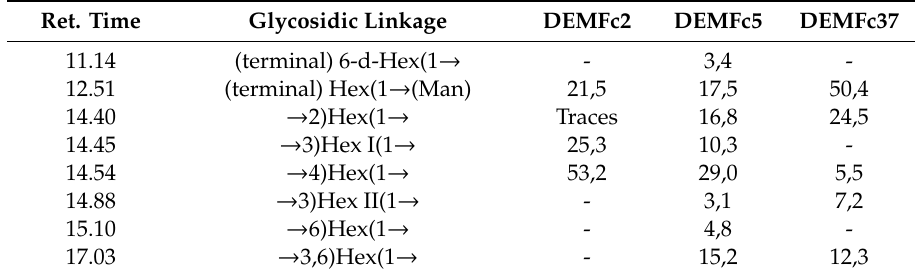
Table 3. Percentage of glycosidic bonds in polysaccharidic components of EPSs (P) from F. culmorum strains (methylation analysis according to the Hakomori procedure [88]. Ret. time